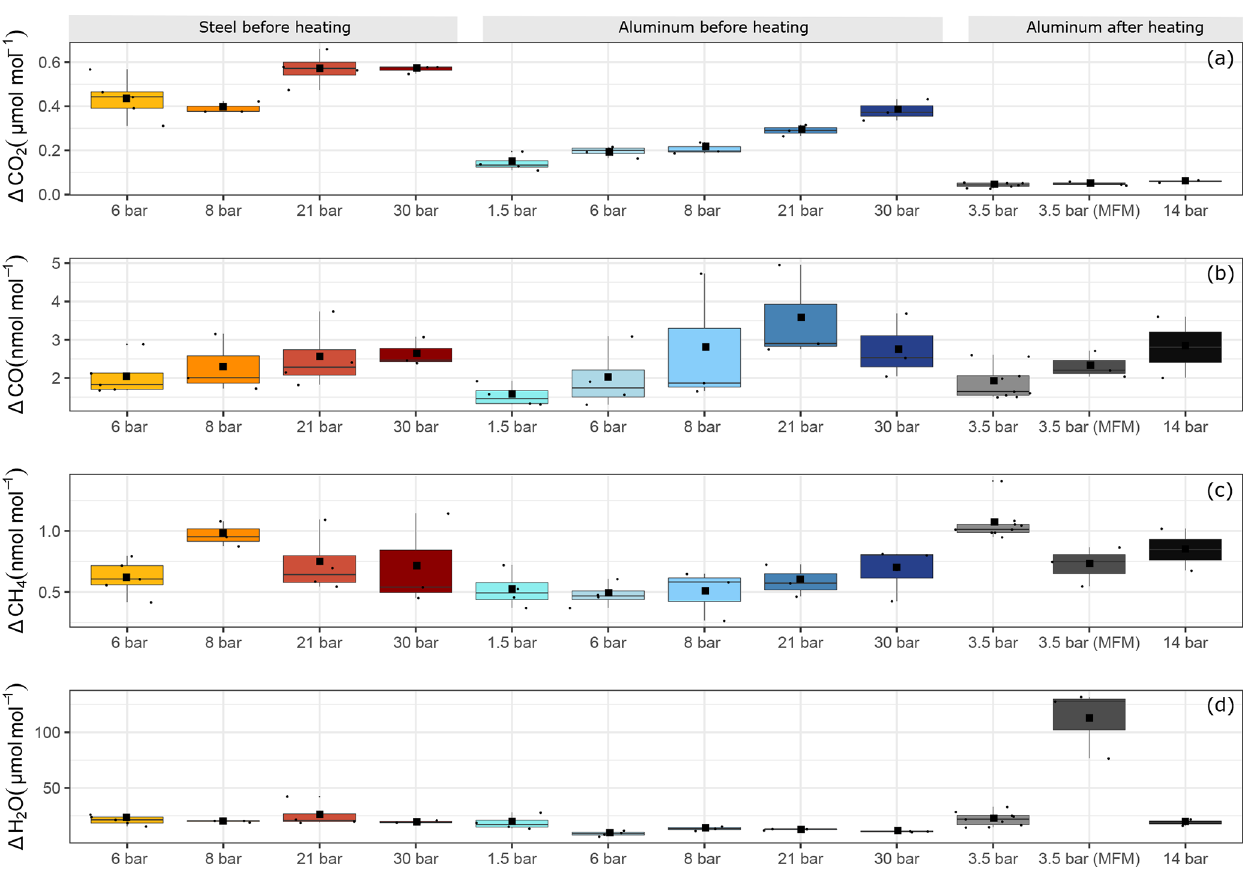
Figure 7. Filling pressure dependency of adsorption process for aluminum and steel cylinders for (a) (cid:49) CO 2 , (b) (cid:49) CO, (c) (cid:49) CH 4 and (d) (cid:49) H 2 O. The y axis shows the maximal amount fraction difference relative to the initial amount fraction. Each boxplot shows the mean of the maximal amount fractions of the replicates in the center of the box denoted by a square, and the median is denoted by a horizontal